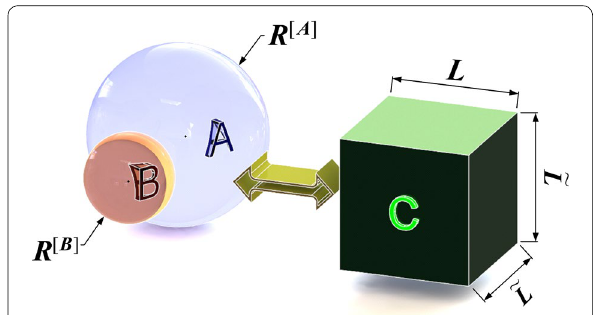
Fig. 5 Contact behavior depicted as a square-section beam.